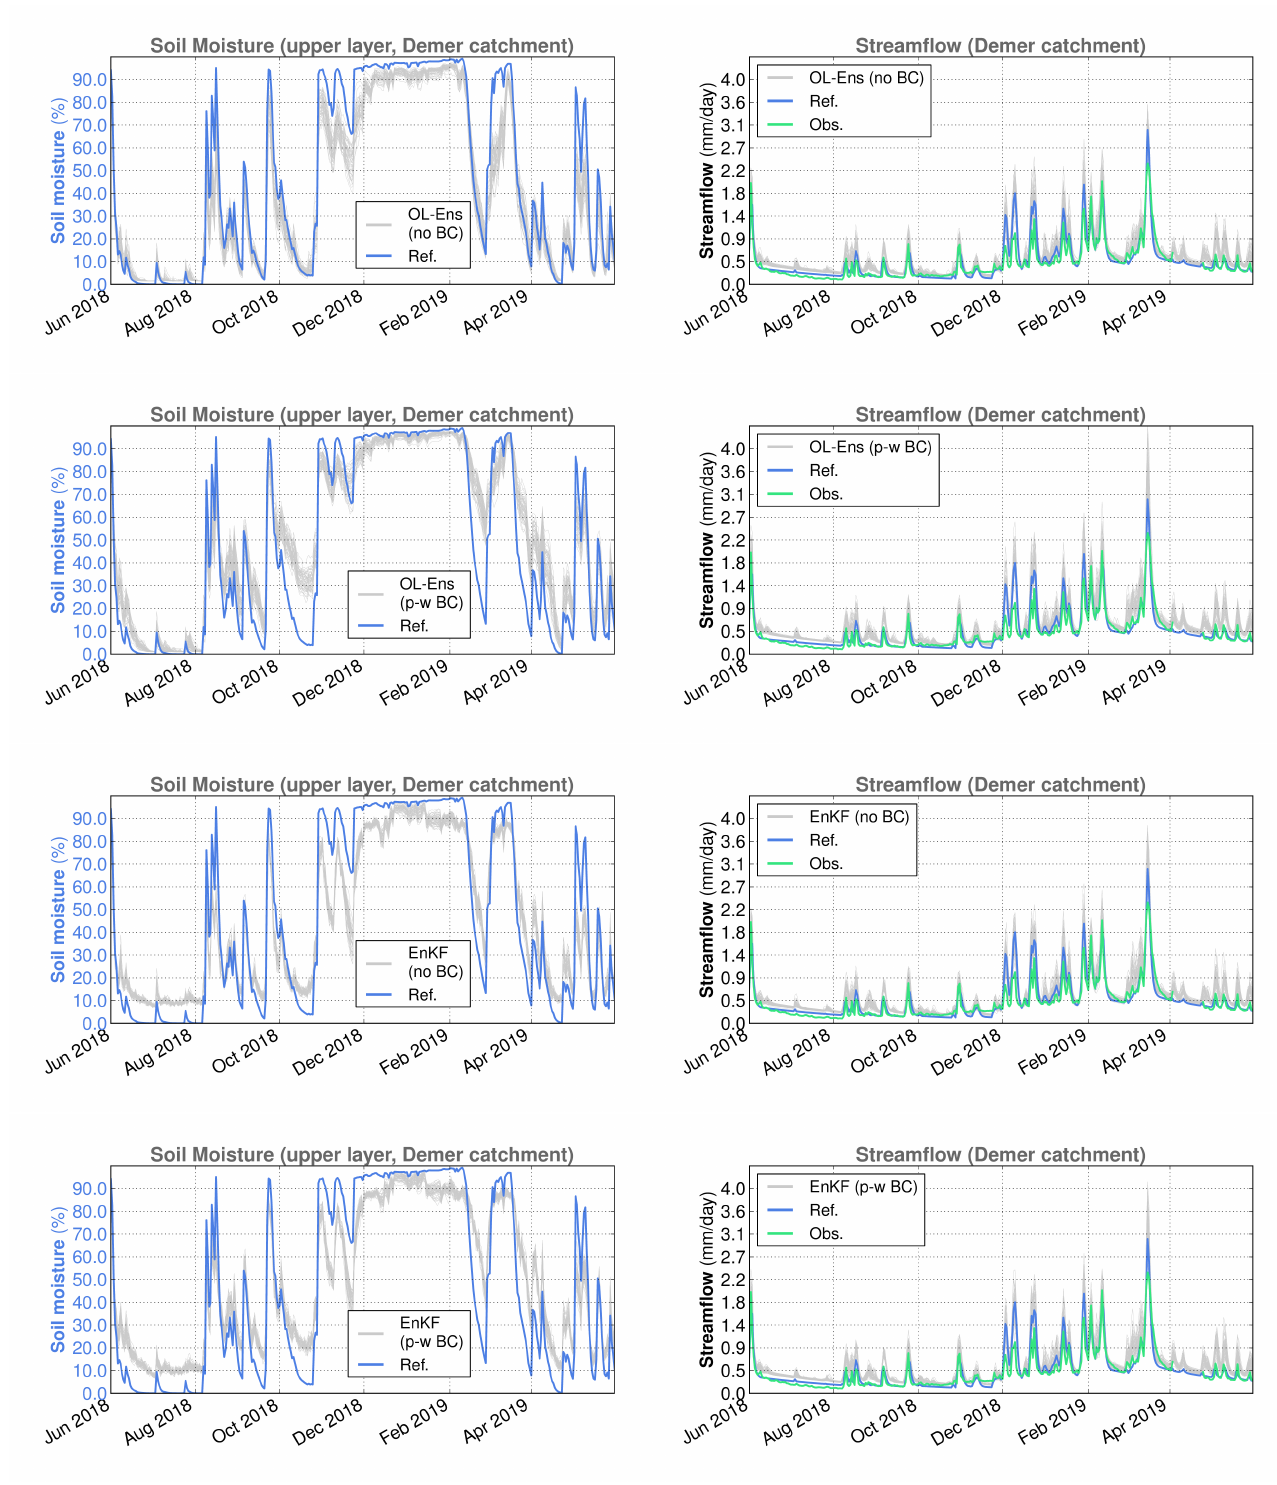
Figure 9. Spatially averaged surface soil moisture (reference simulation and ensemble members) and streamflow (reference simulation, observations and ensemble members) for the Demer catch- ment in SCHEME model simulations, June 2018–May 2019. From top to bottom: OL without bias correction, OL with piece-wise bias correction, EnKF without bias correction, EnKF with piece-wise bias